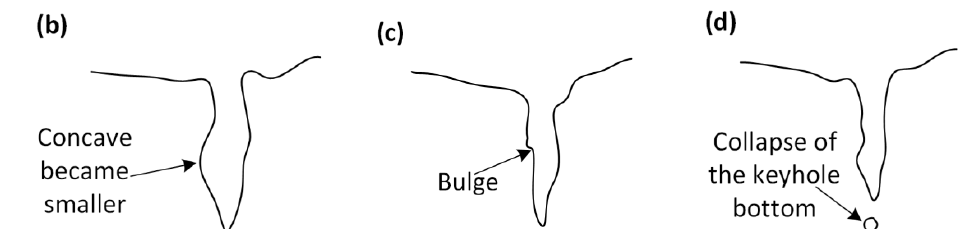
Figure 11. The process of generating spatter around the keyhole: ( a ) the concave area forms in the middle of the inner wall of the keyhole, ( b ) the concave area becomes smaller in the middle of the keyhole wall, ( c ) the spatter forms at the opening of keyhole.